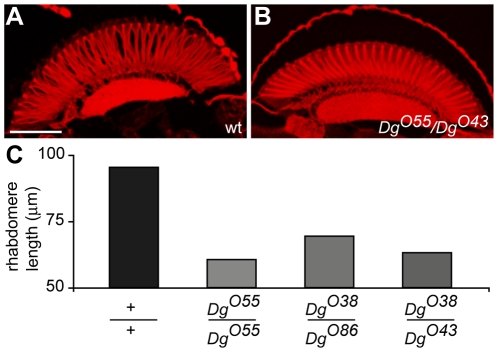
Dg mutants have thin retinas.(A, B) Transverse retinal sections of adult eyes stained with F-actin to highlight the R cell rhabdomeres. The retina of DgO55/DgO43 (B) is thinner than wild type (A) and R cells are obviously shorter. (C) Chart shows mean rhabdomere lengths in wild type and Dg mutants (wild type n = 30; DgO55/DgO55 n = 51; DgO38/DgO86 n = 23; DgO38/DgO43 n = 14). Scale bars in (A) represents 75 µm.